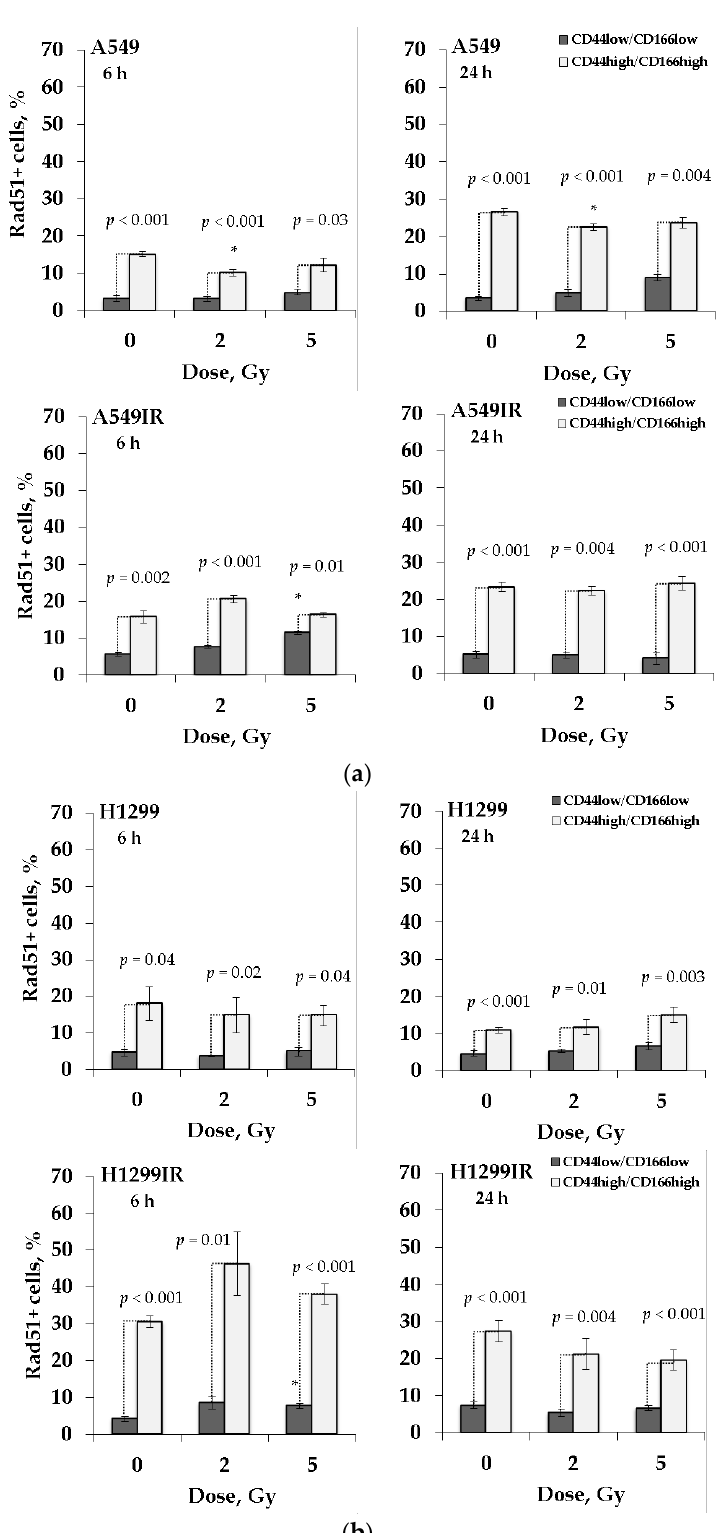
Figure 6. The proportion of Rad51 positive cells in the CD44low/CD166low and CD44high/CD166high populations of MFR-surviving and their parental NSCLC cells at 6 h and 24 h after exposure to 2 Gy and 5 Gy of X-ray: A549IR and A549 cells ( a ); H1299IR and H1299 cells ( b ). * p < 0.05. Data are means ± SEM of more than three independent experiments. CD44high/CD166high population than in the CD44low/CD166low population in all